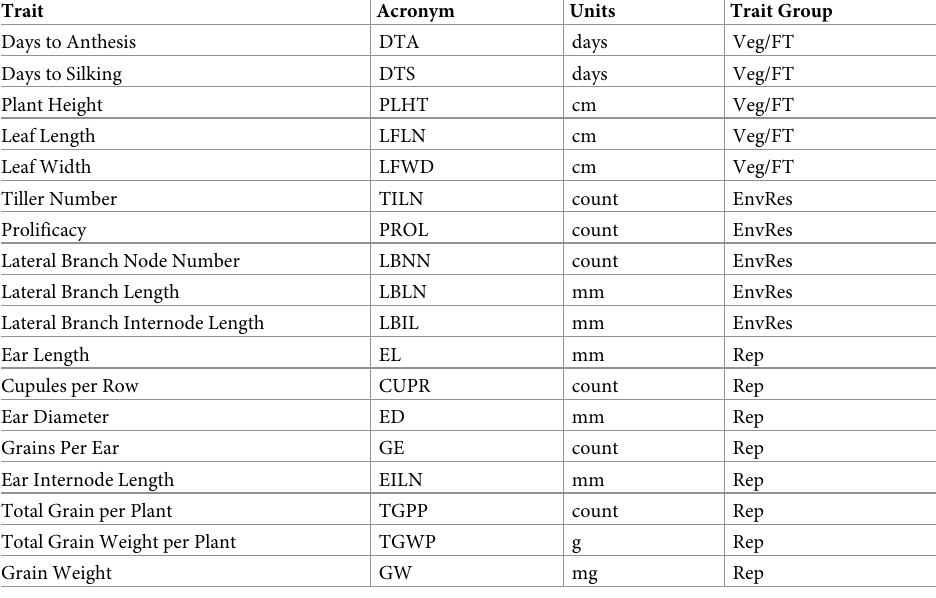
Table 1. Trait Abbreviations. List of 18 teosinte-maize landrace comparable traits and the corresponding acronyms, units and trait groups. From Yang et al. (2019). Trait Acronym Units Trait Group Days to Anthesis DTA days